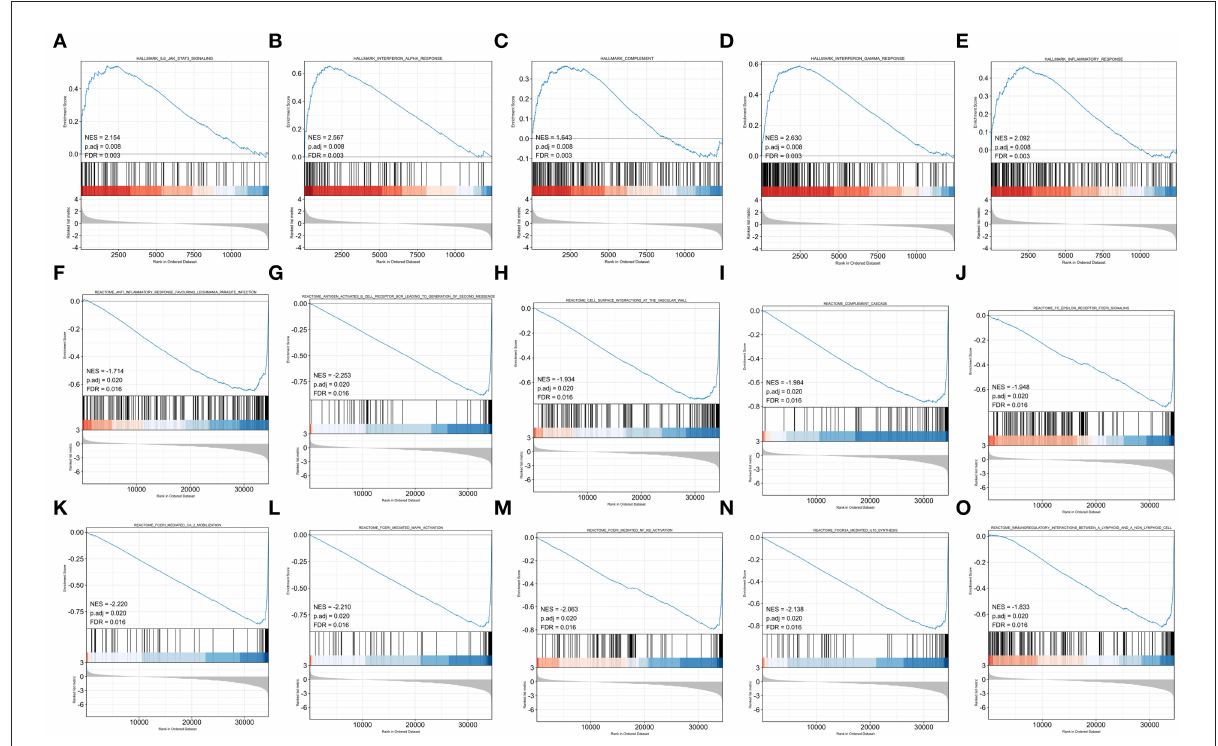
FIGURE2 Gene set enrichment analysis (GSEA) of abatacept treatment and SARS-CoV-2 infection. (A–E) Five representative gene sets enriched in whole blood with abatacept treatment. (F–O) Ten representative gene sets enriched in PBMC with SARS-CoV-2